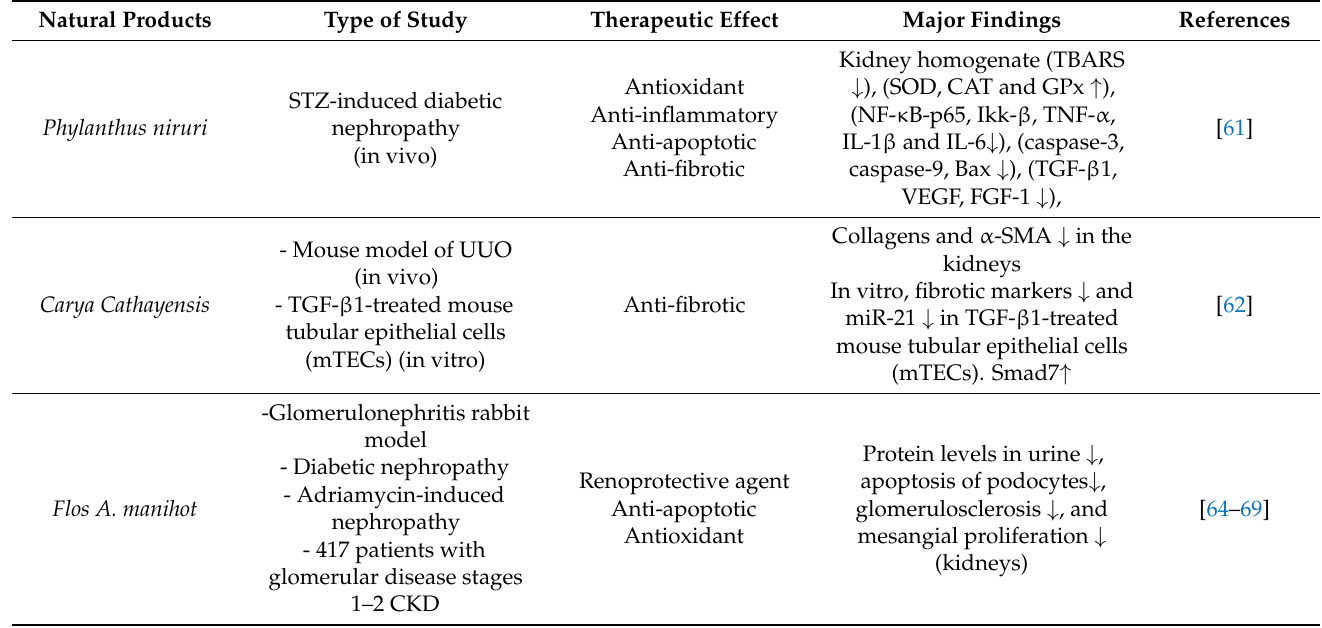
Table 1. Summary of clinical and experimental studies evaluating the protective effect and the possible mechanisms of different natural products against CKD. Decreased ( ↓ ) or increased ( ↑